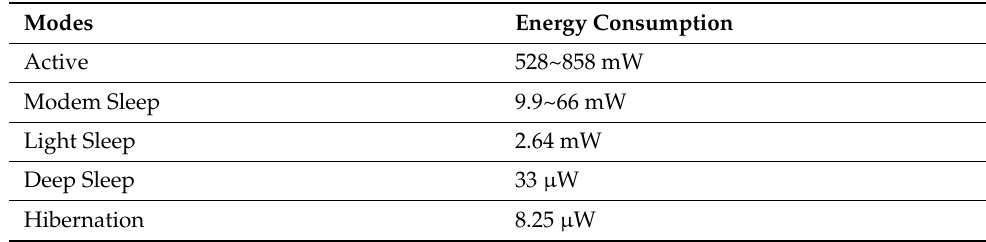
Table 1. Power consumption of ESP32 module.